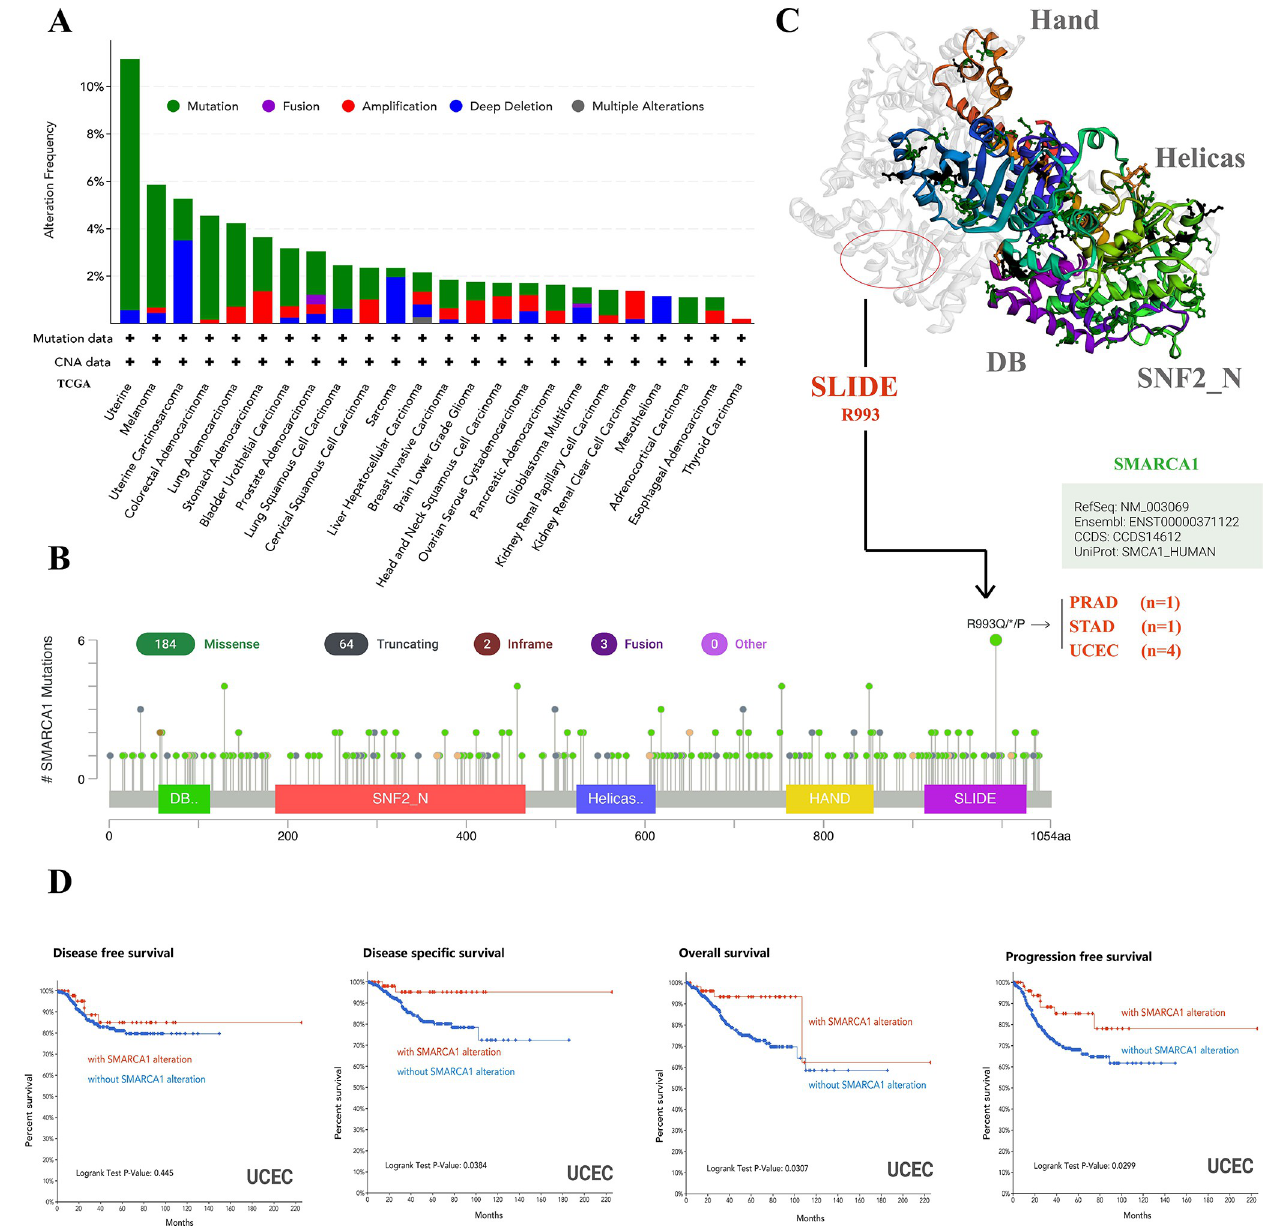
Fig 8. Genetic variation features of SMARCA1 in different cancers based on TCGA via cBioPortal. (A) The alteration frequency and types among diverse cancers; (B) Potential sites of mutation; (C) mutation site with highest frequency (R993Q/ � /P) in the 3D version of SMARCA1 and related carcinomas; (D) Prognosis analysis between SMARCA1 alteration and OS, DSS, DFS, and PFS of uterine corpus endometrial carcinoma (UCEC) by the cBioPortal. � P <